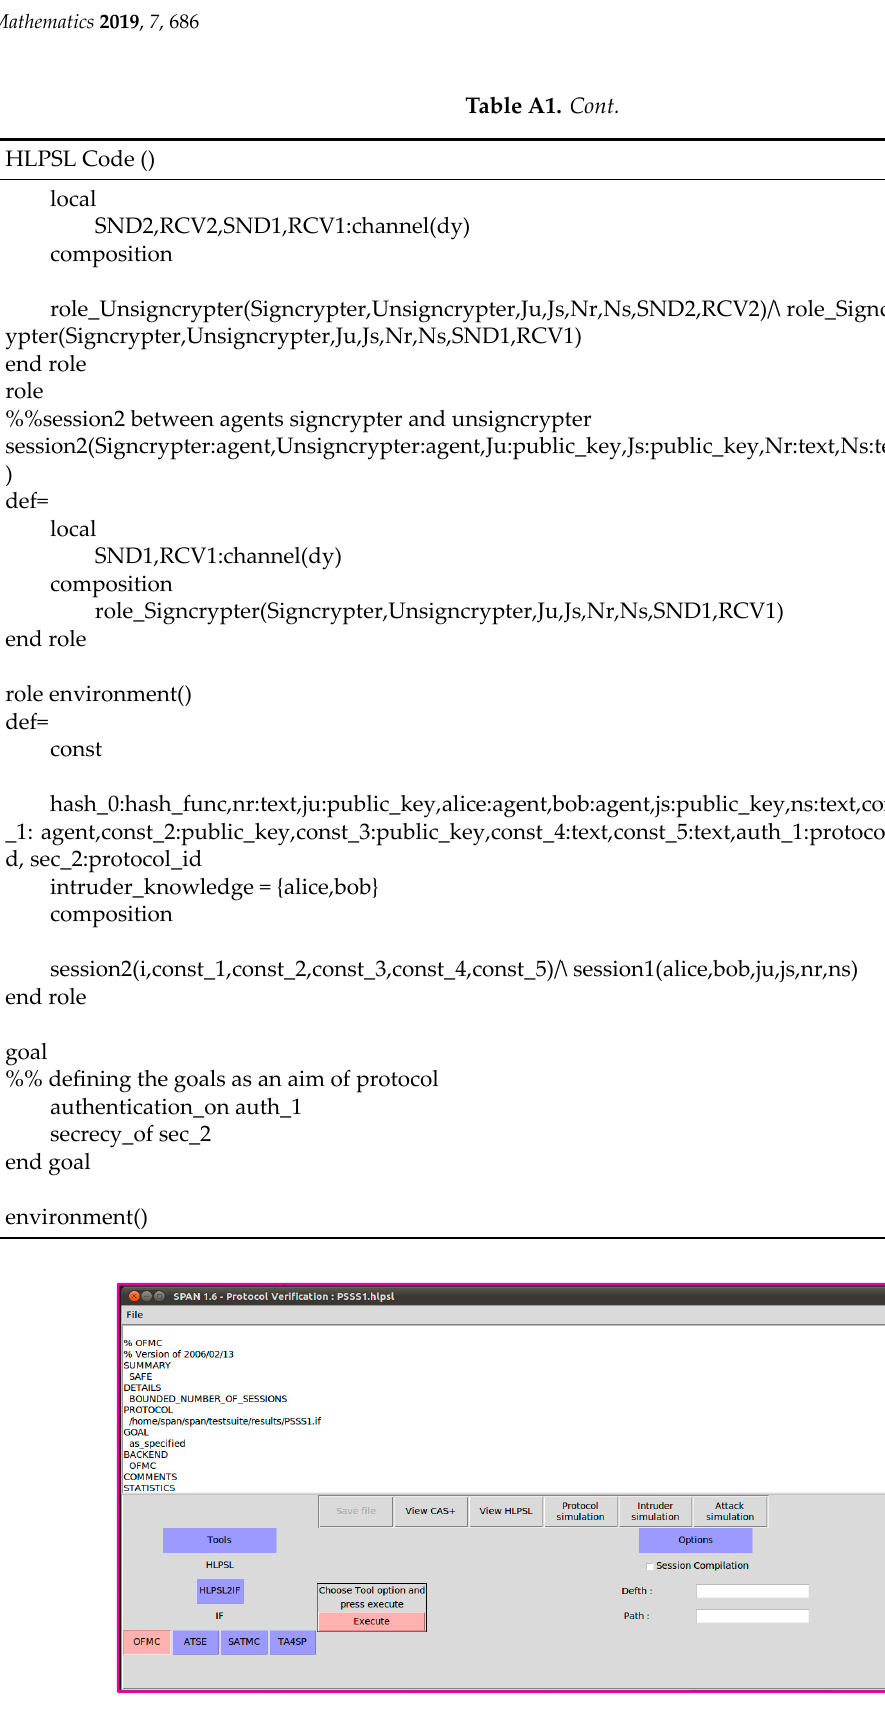
Figure A1. OFMC simulation